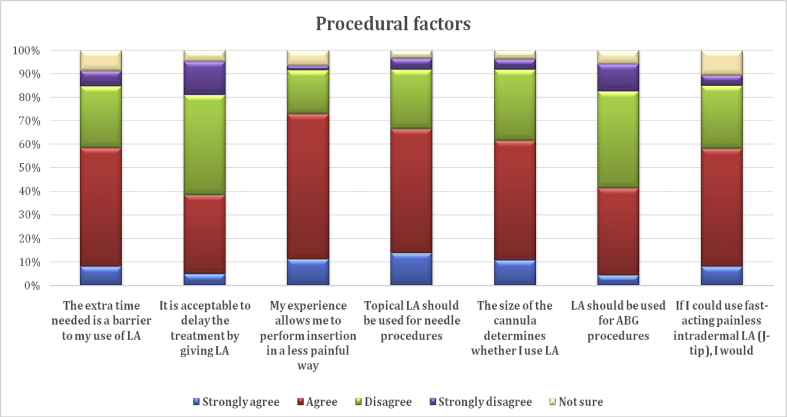
Procedural factors.